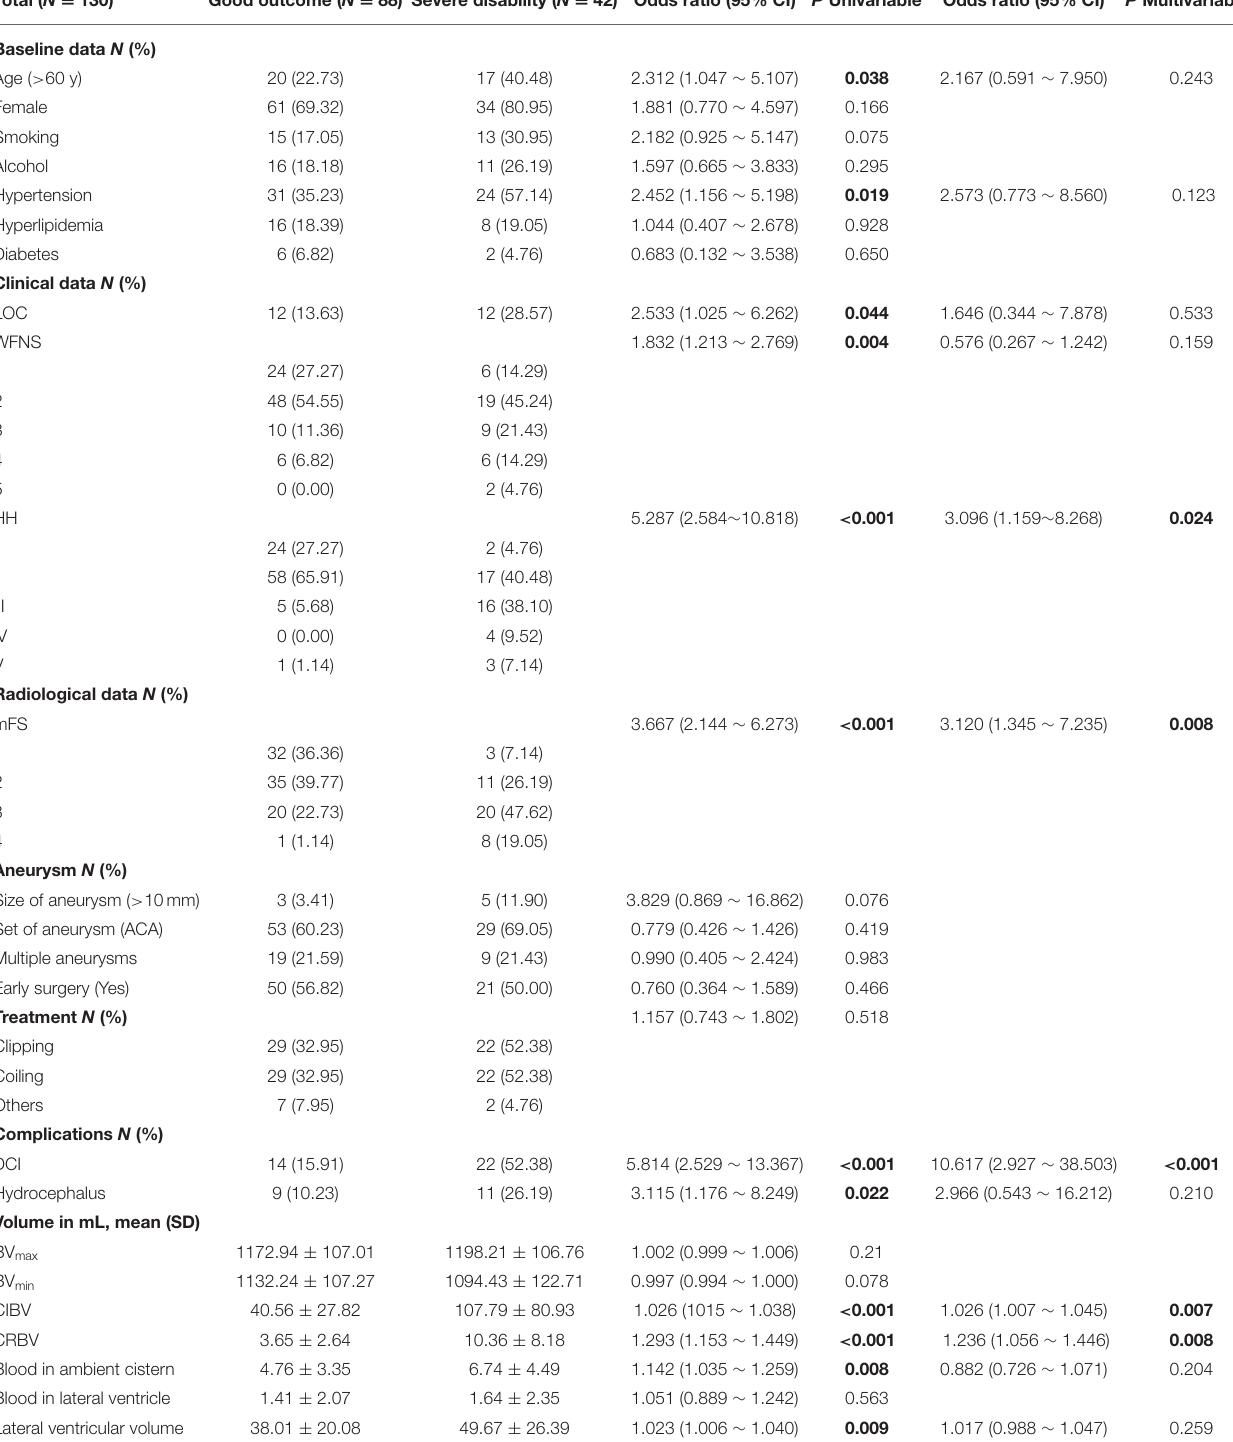
TABLE 4 | Predictors of outcome. Total ( N = 130)